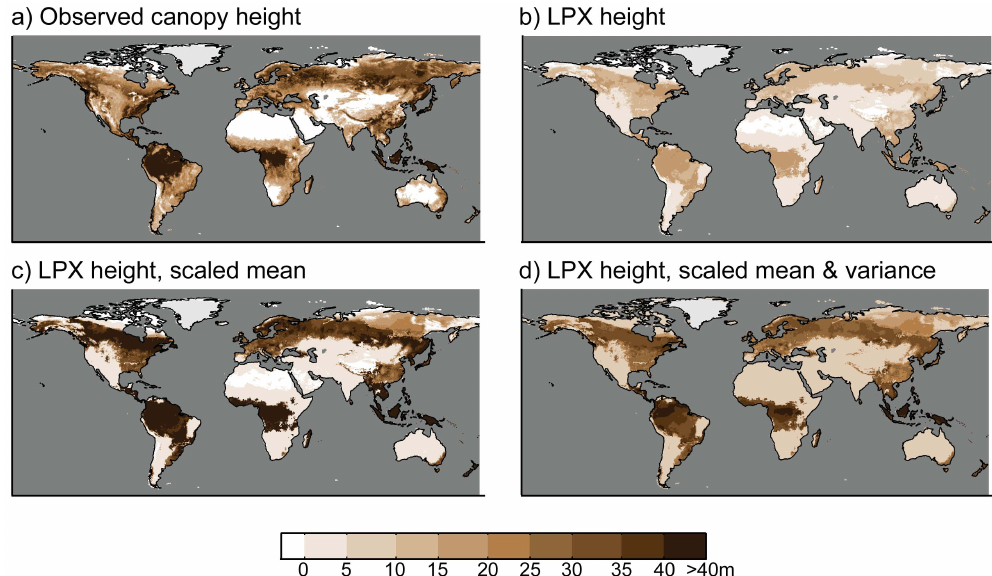
Fig. 6. Comparisons of observed and simulated height. (a) Observed canopy height (in 2005) from the Simard et al. (2011) dataset compared to (b) simulated height in the same year from LPX; (c) LPX-simulated height, multiplied by a factor of 2.67 so that the simulated global mean height is the same as the observations; (d) height from (c) with values reduced by a factor of 1.40 about the mean so that the simulations have the same global mean and variance as the